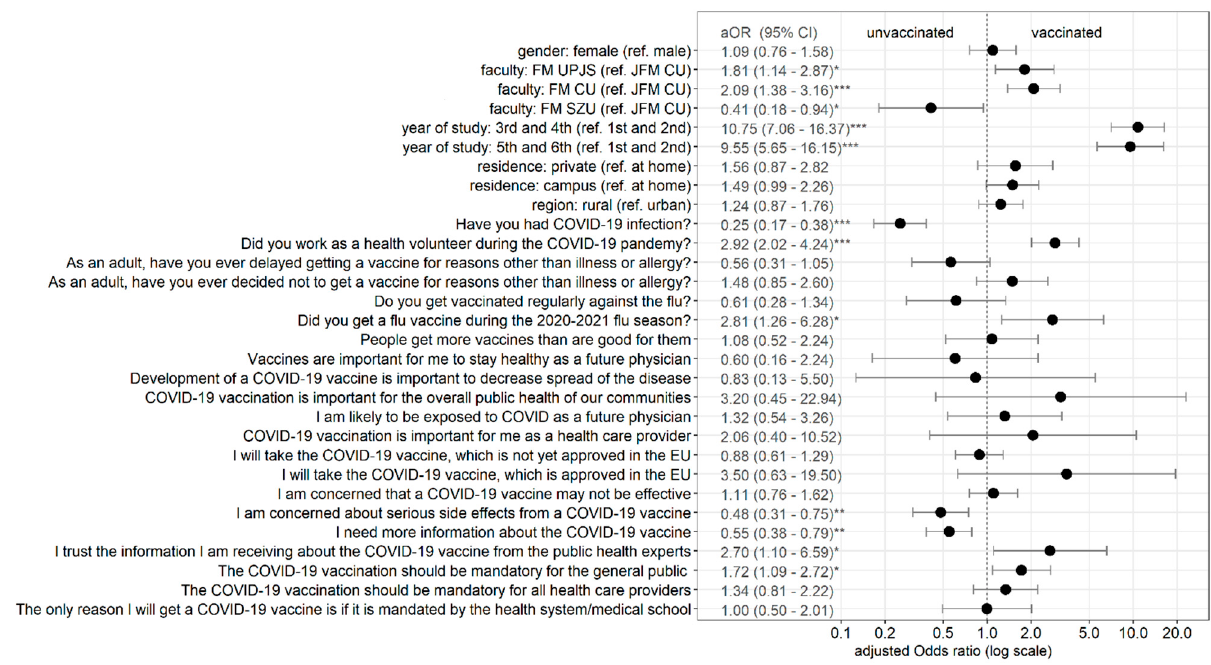
Figure 2. Predictors of COVID-19 vaccination status among medical students—multivariate logistic regression analysis. Note: * p < 0.05; ** p < 0.01; *** p < 0.001; Reference category in attitudes questions is not affirmative (no or disagree + strongly disagree).